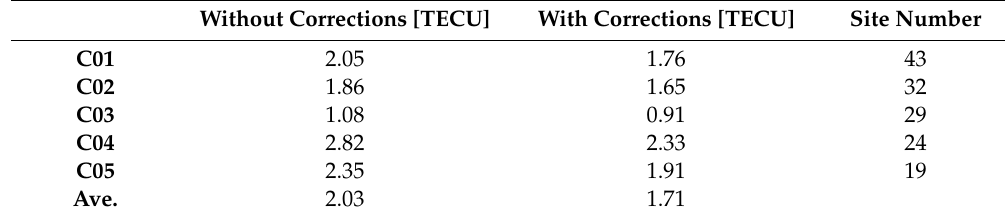
Table 2. Root mean square error (RMSE) of the ionospheric residual without and with the corrections of multipath error.